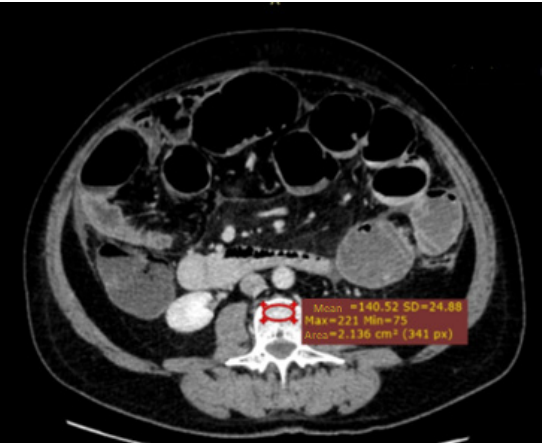
Figure 1. Osteopenia assessment—ROI (region of interest)—anterior trabecular area of the vertebrae on an axial projection at the L3 level.